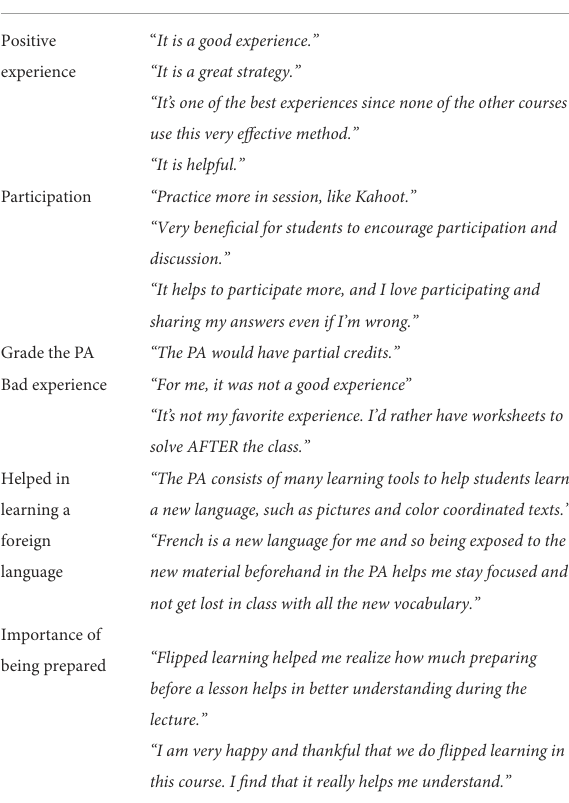
TABLE 7 Student responses to the statement: Please share any comments you have about this experience with “flipped